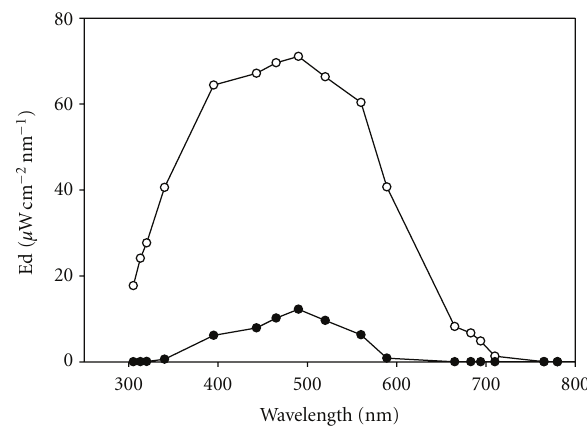
Figure 1: In situ transmitted downwelling irradiance (Ed) at 6 m (open circles) and 30m (closed circles) measured with the PRR-800 (BioSpherical Instruments) on April 1, 2008, o ff shore the